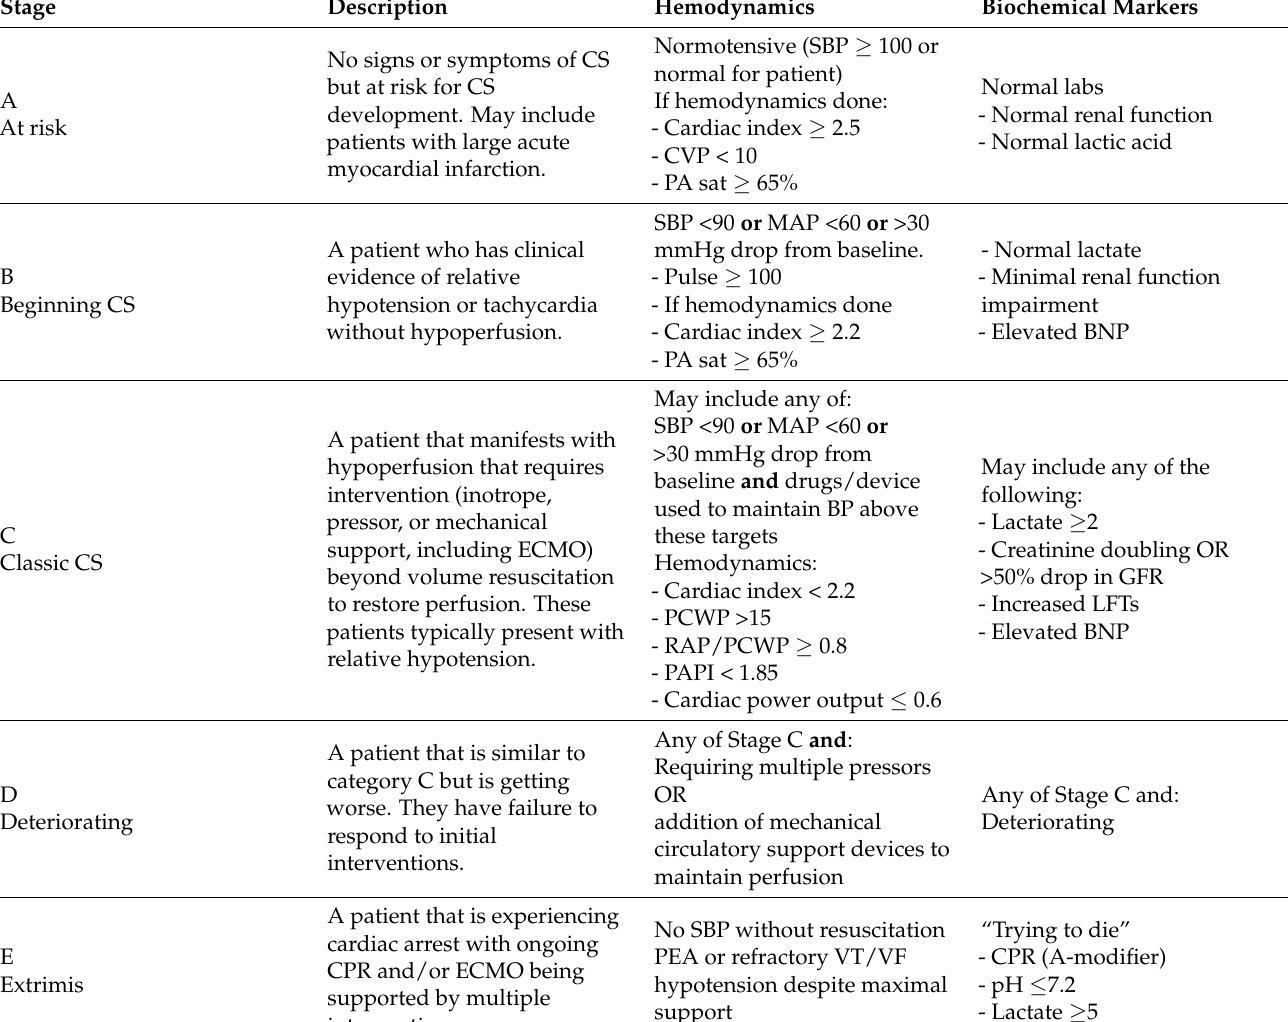
Table 1. Shock stages: description and